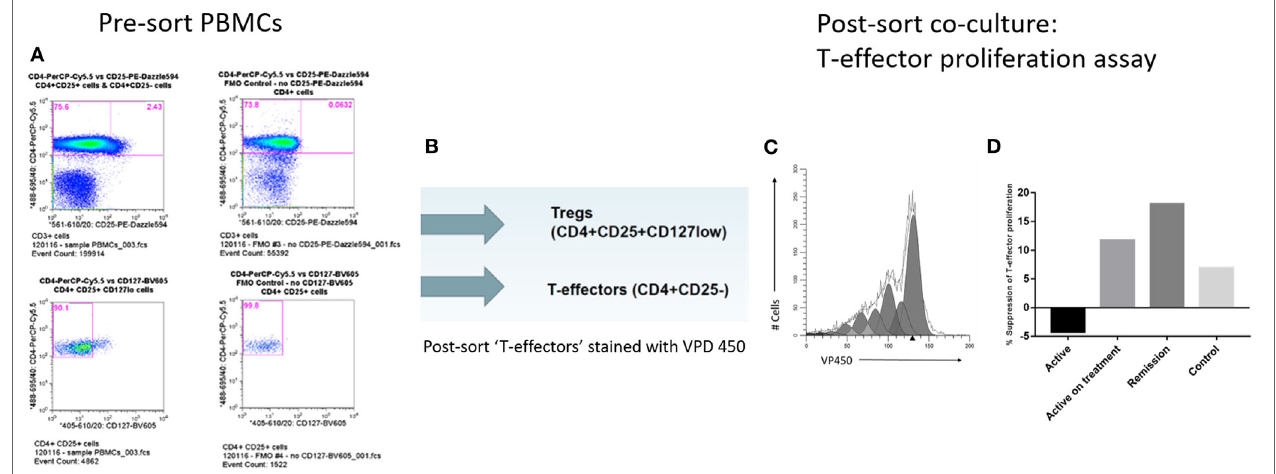
FigUre 2 | Cell sorting and T-regulatory cell (Treg) suppression assays. (a) Cell sorting strategy to isolate Treg (CD4 + CD25 + CD127 lo ) and T-effectors (CD4 + CD25 − ) in CD3 + T-cell subset. (B) Post-cell sort staining of T-effectors with violet proliferation dye (VPD) 450 cell tracking dye. (c) Modfit modeling of in vitro T-cell proliferation index using VPD 450. (D) Comparison of % suppression of T-cell proliferation by Treg isolated from the different subject